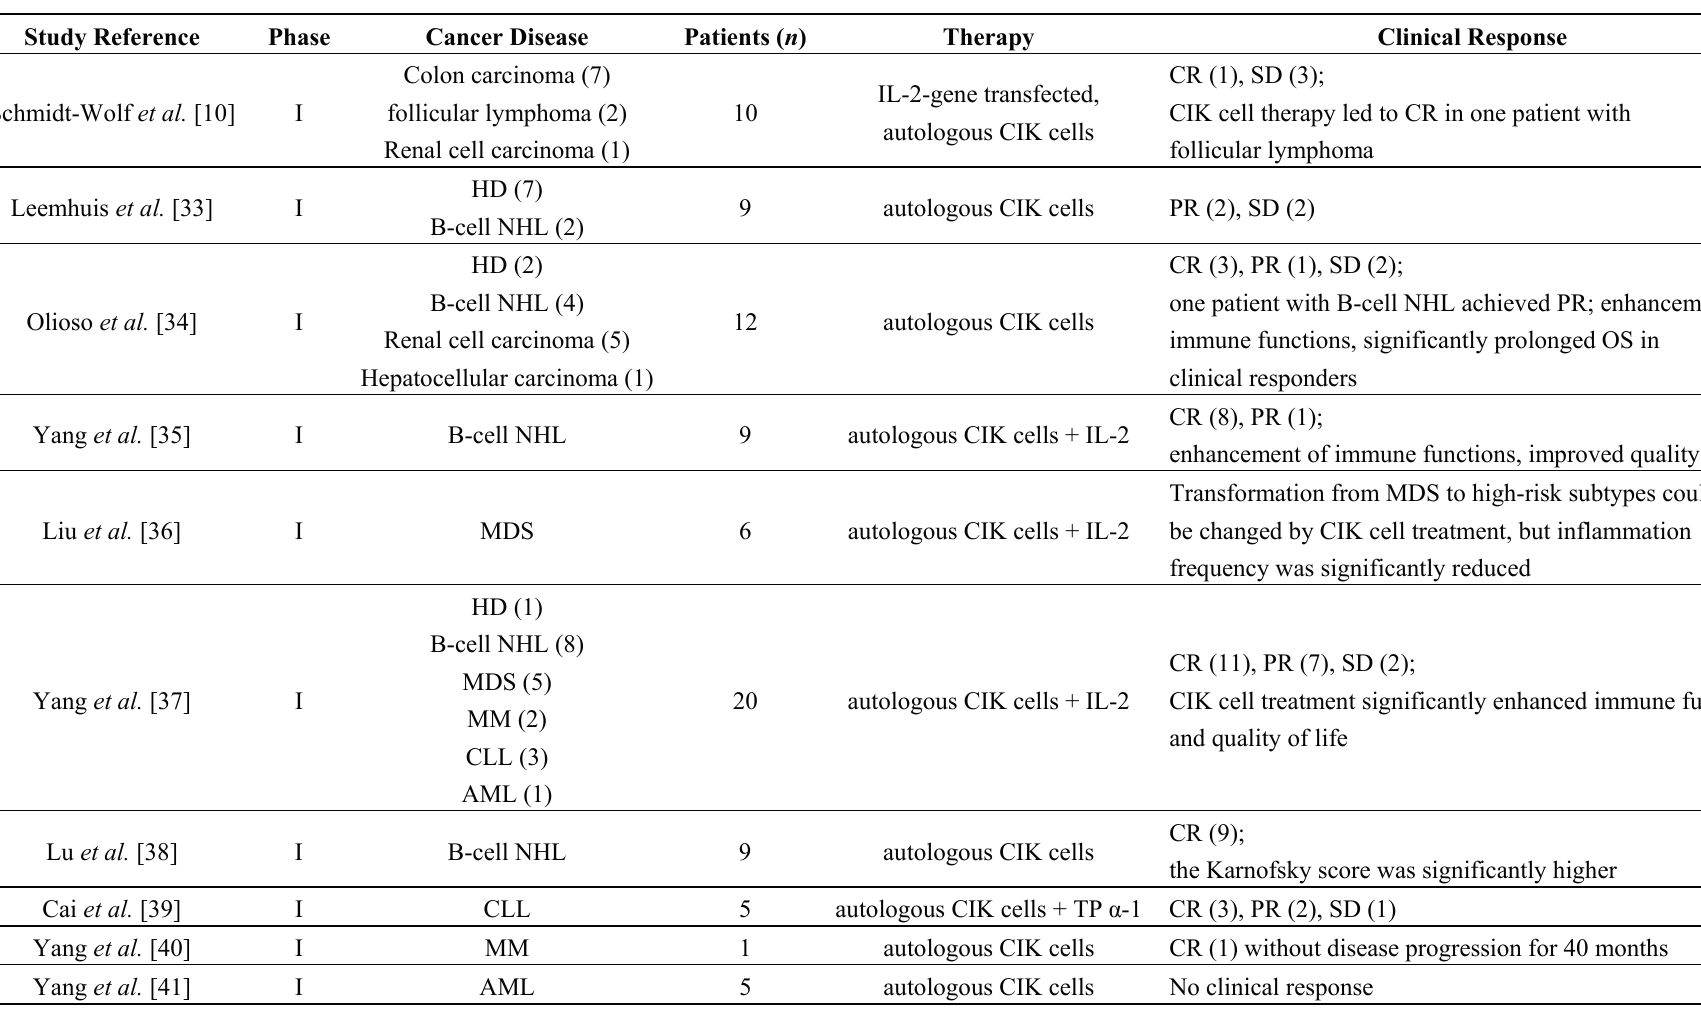
Table 2. Clinical studies using CIK